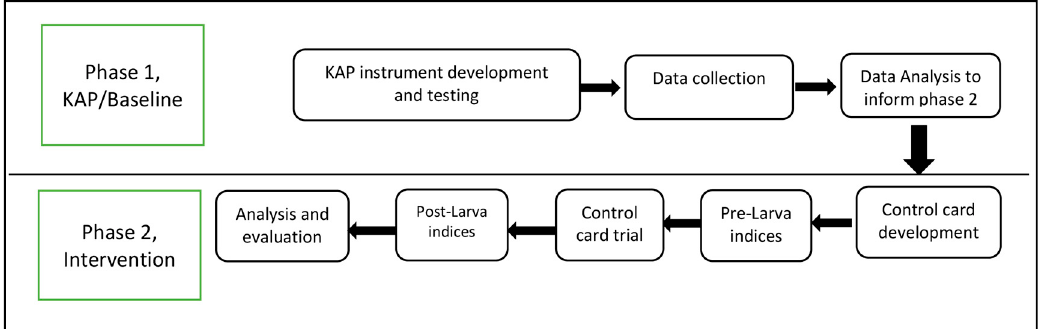
Figure 1. Schematic illustration of the study design.